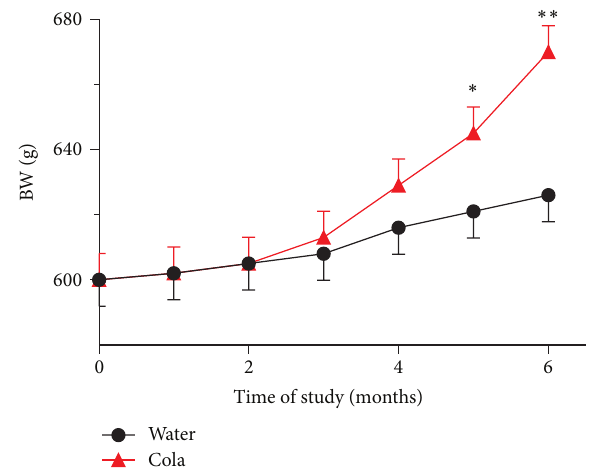
Figure 2: Body weight (BW) over the time of study. ∗ 𝑝 < 0.05 and ∗∗ 𝑝 < 0.01 versus water drinking group.